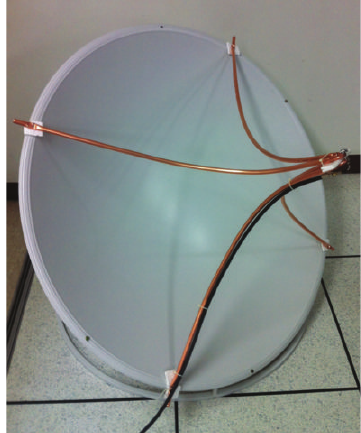
Table 1: Parameter values for TEM-wire horn curves with a narrow throat. Values in the parentheses are for a wide throat. (unit: mm). The radius of wires is set to 5mm.